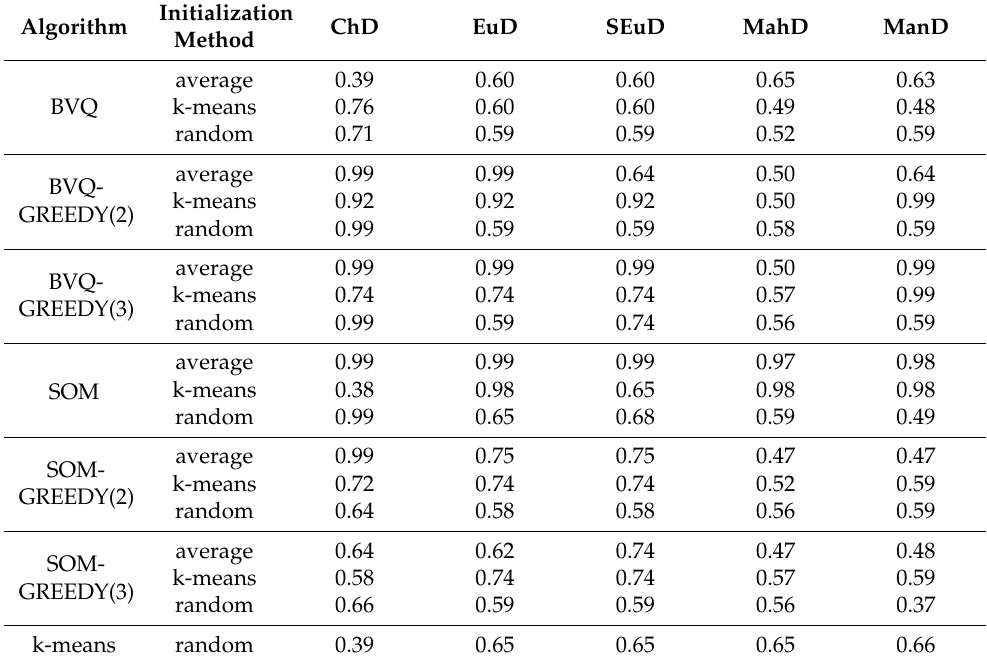
Table 8. Accuracy of device clustering for BVQ, SOM, BVQ-GREEDY(2), BVQ-GREEDY(3), SOM- GREEDY(2) and SOM-GREEDY(3) algorithms (four-batch mixed